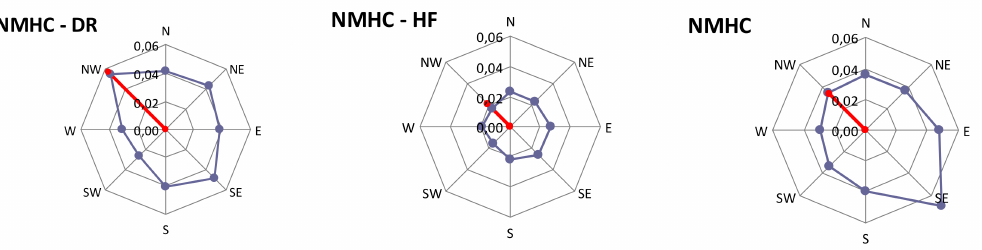
Figure A5. Average levels of NMHC vs. wind direction measured at the Stary Wiec station during drilling (DR), hydrofracturing (HF), and for the remaining period of measurements. Concentration units for NMHC are